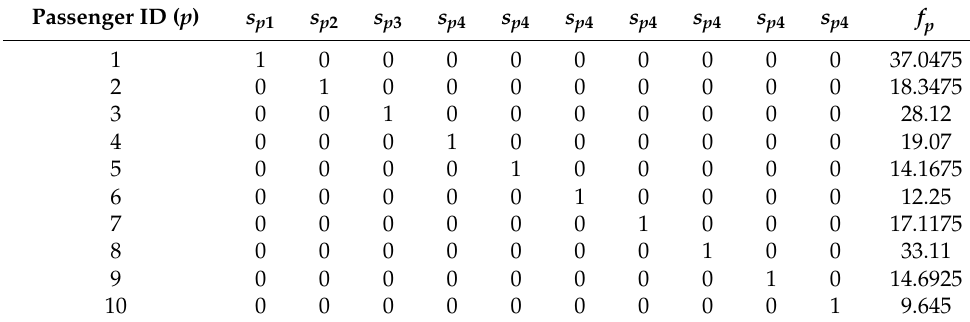
Table 8 shows the number of seats and price information in the bids submitted by passengers. Table 8. Bids submitted by passengers.